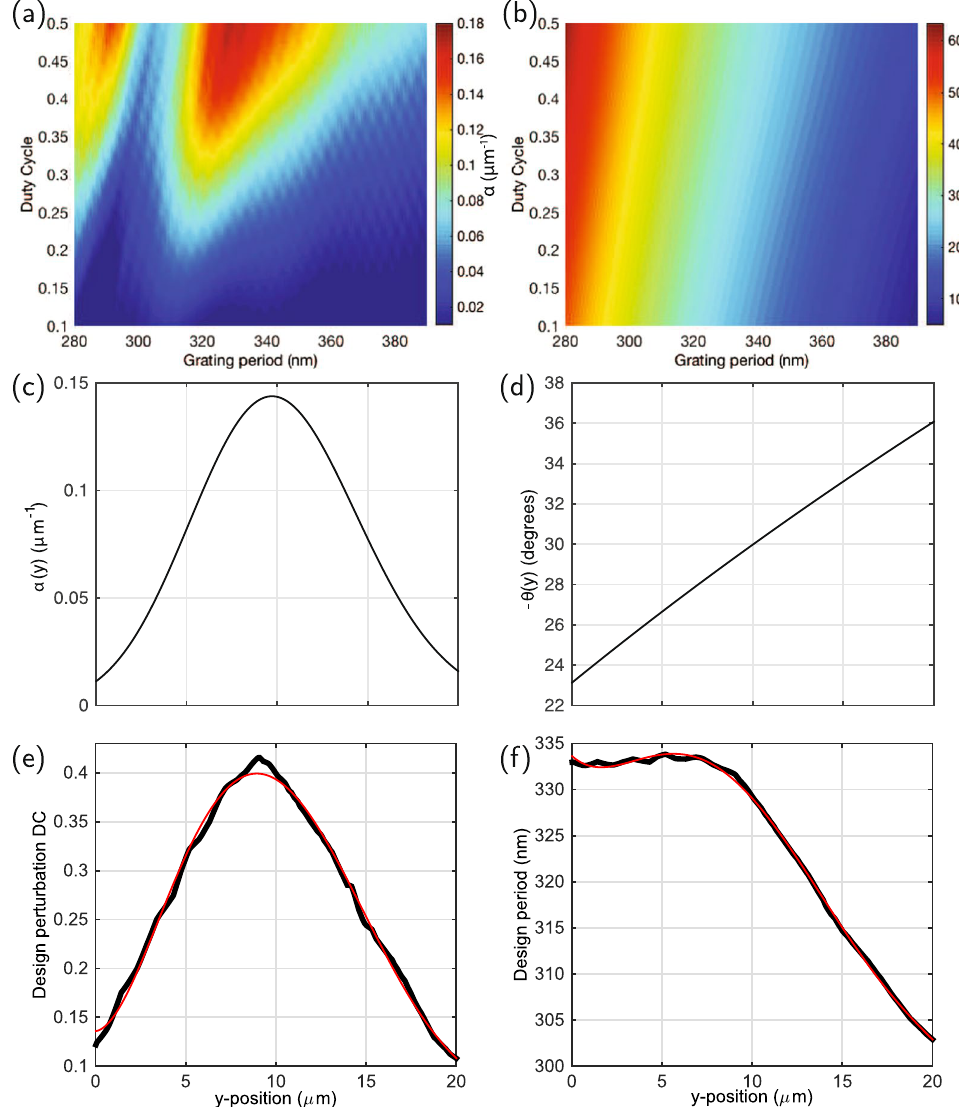
Figure 2. Grating design parameters. ( a ) Simulated α and ( b ) θ as a function of grating period and DC; ( c ) Desired local α and ( d ) local θ to produce the intended focus for a grating 20 μ m-long along y ; ( e ) and ( f ) inferred physical DC and Λ profiles to approximate the desired grating (black lines), together with polynomial fits used to specify the